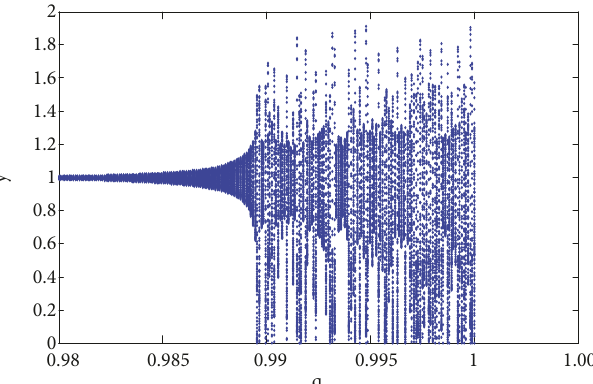
Figure 1: Bifurcation diagram with the change of q.